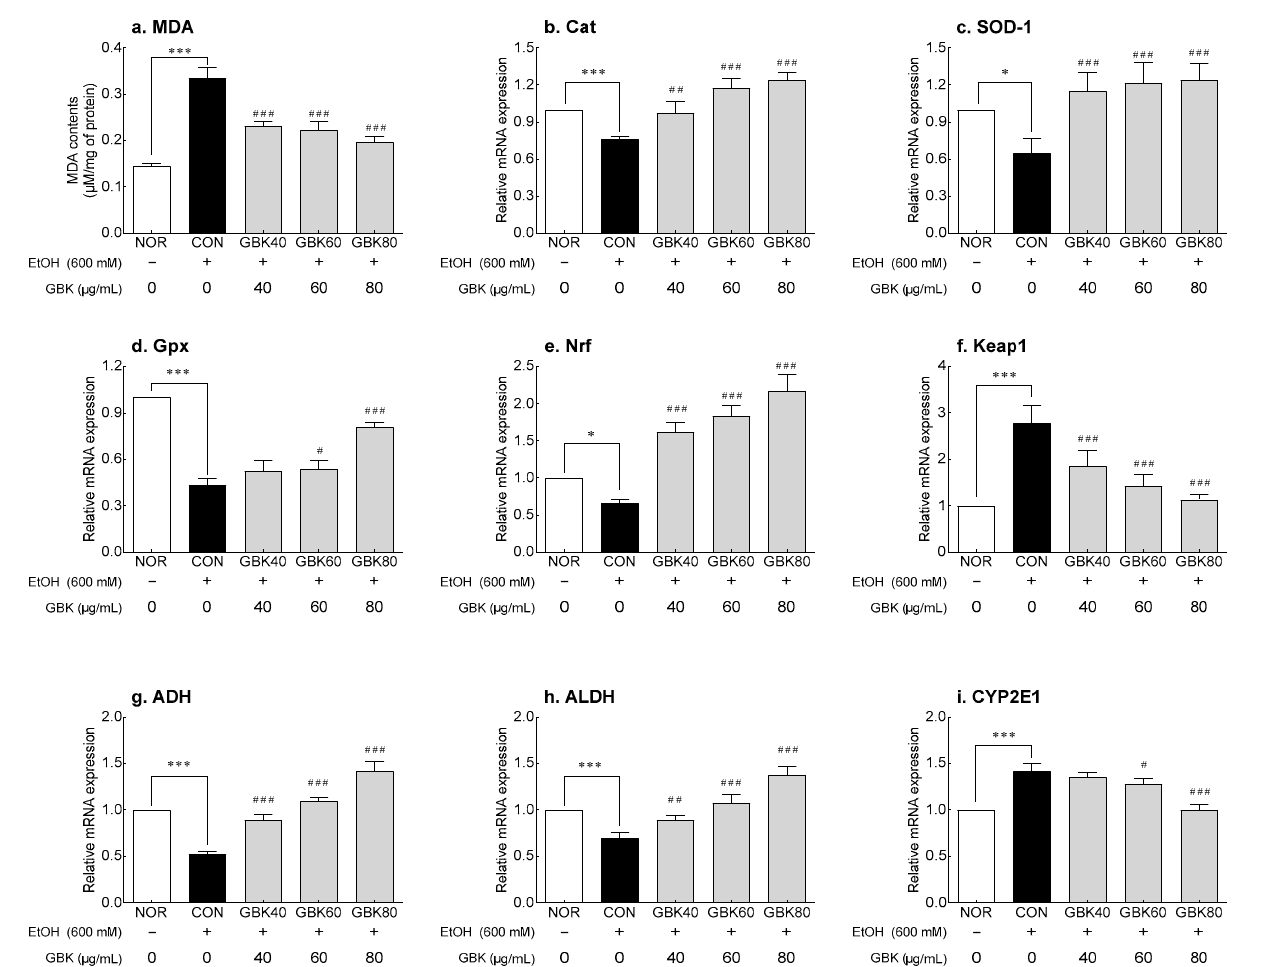
Figure 3. Effects of GBK on ( a ) malondialdehyde content and mRNA expression of factors related to ( b – f ) oxidative stress and ( g – i ) alcohol metabolism in ethanol-treated HepG2 cells. HepG2 cells were treated with GBK in the presence or absence of ethanol for 24 h. Values are mean ± SD. * p < 0.05 and *** p < 0.001 vs. NOR group; # p < 0.05, ## p < 0.01, and ### p < 0.001 vs. CON group (ANOVA followed by Tukey’s test). EtOH, ethanol; MDA, malondialdehyde; Cat, catalase; SOD-1,